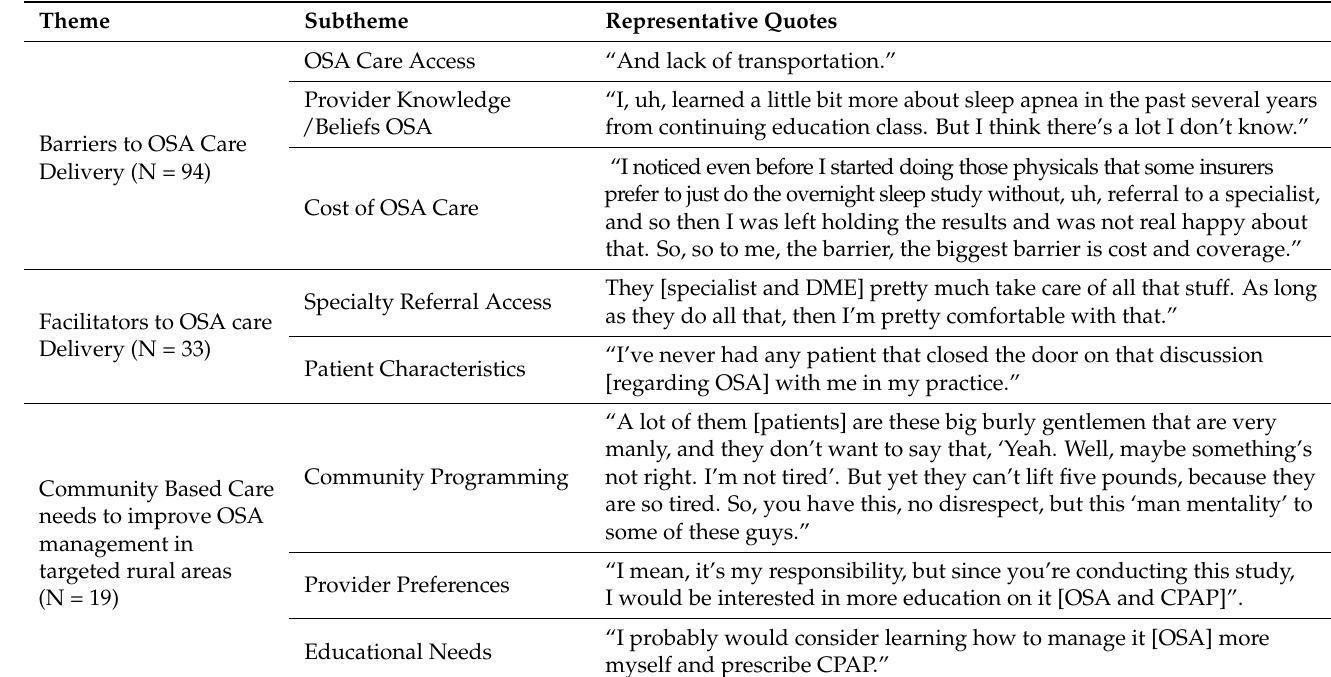
Table 4. Categorization of Themes and Subthemes with Representative